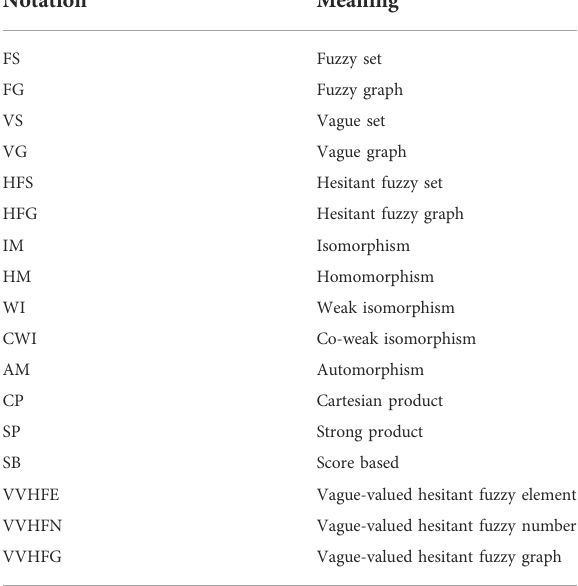
TABLE 1 Some essential